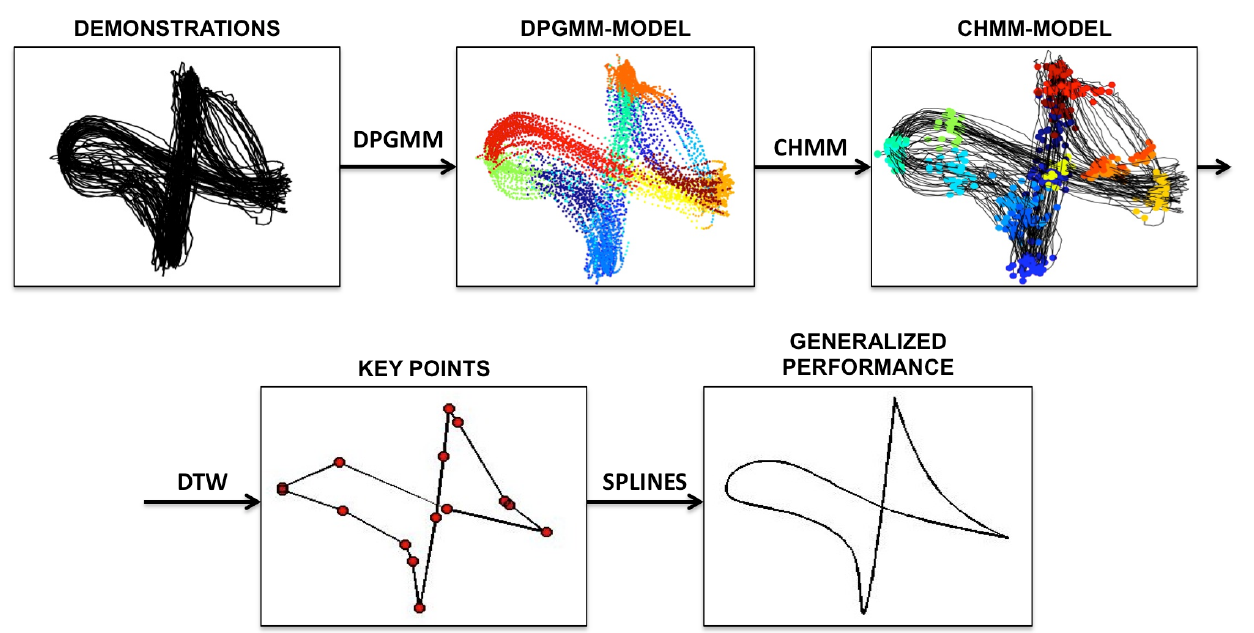
Figure 2. Flow Chart of the followed procedure for PbD. (i) DPGMM, as front-end for a continuous HMM, is used to calculate its number of hidden states and to set its initial emission values. (ii) a cHMM defines the key points which are used to create a reference signal for (iii) DTW. Eventually (iv) non-uniform cubic spline regression on the warped gestures produces a smooth generalised gesture.